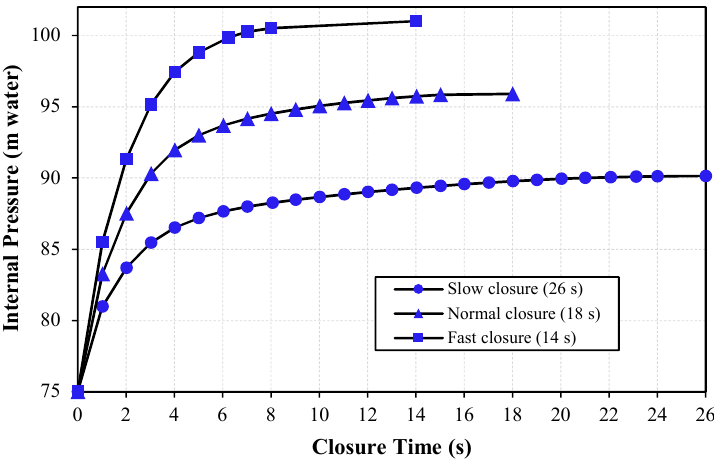
Figure 12. Changes in pressure upstream of the gate, in different scenarios: 14 s, 18 s, and 26 s.